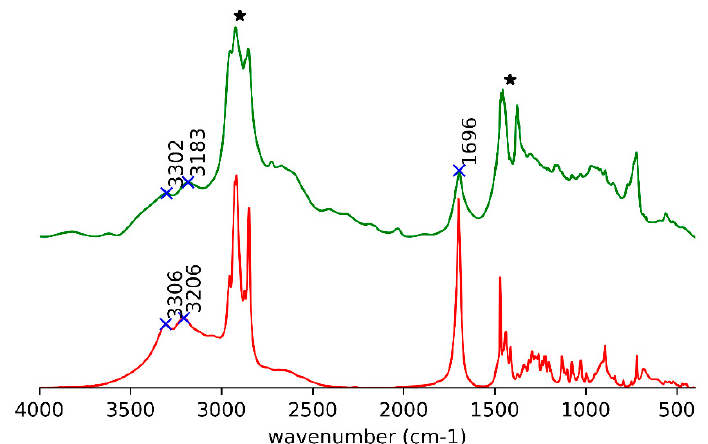
Figure 3. IR spectra for gel in paraffin oil (green trace with the strongest signals, attributed to paraffin oil, marked by asterisks) and heat-treated ( R )-10-HSA (red trace).